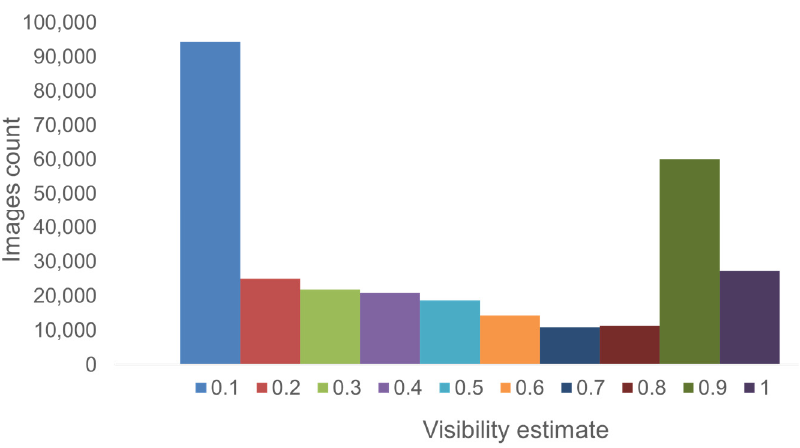
Figure 11. A distribution of images count by visibility estimate. Each bar represents count of images with estimate below the corresponding x-value.